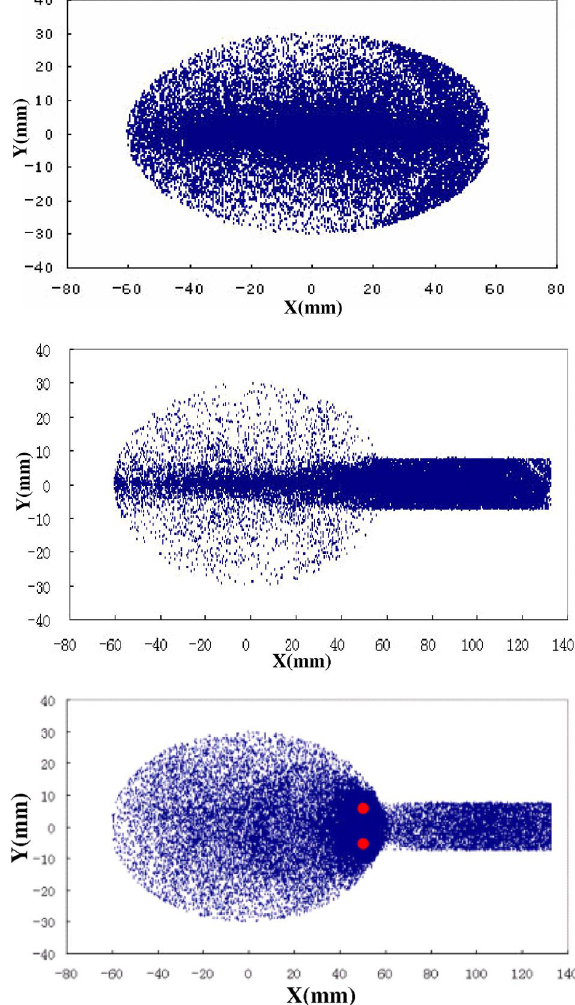
FIG. 13. (Color) The electron cloud distribution in the ellip- tical chamber (top), in the antechamber (middle), and in the antechamber with electrode